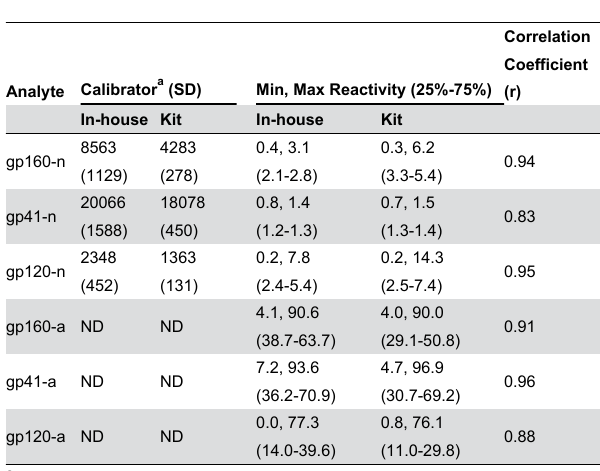
Table 1. Comparison of in-house, HIV-1-specific Bio-Plex assay and prototype